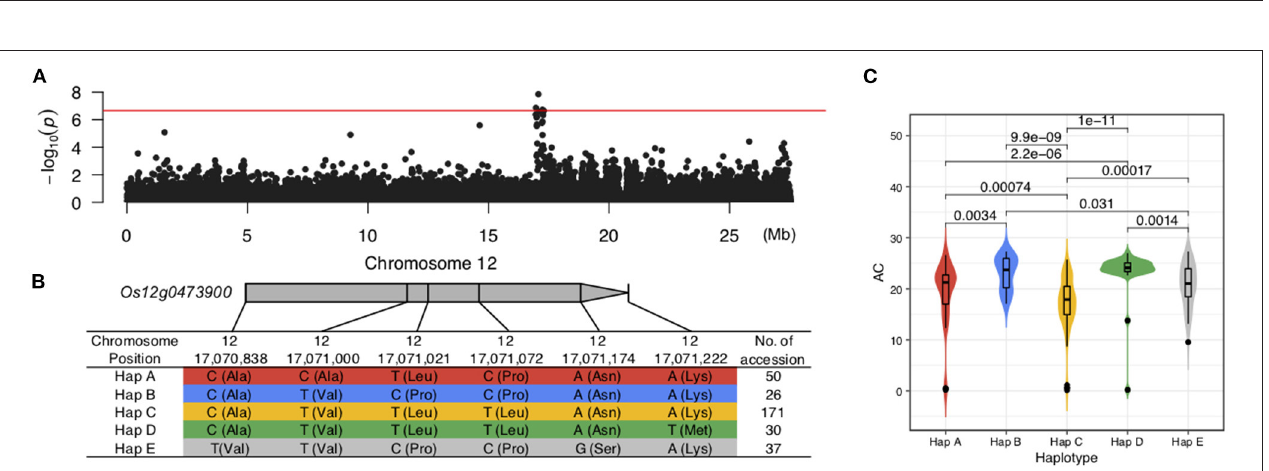
FIGURE 8 | Candidate genes in qAC12-1 . (A) Manhattan plot of AC on Chromosome 12. (B) Five haplotypes were defined by six missense SNPs in Os12g04739900 . (C) Significant differences were identified among the five haplotypes from Os12g04739900 .